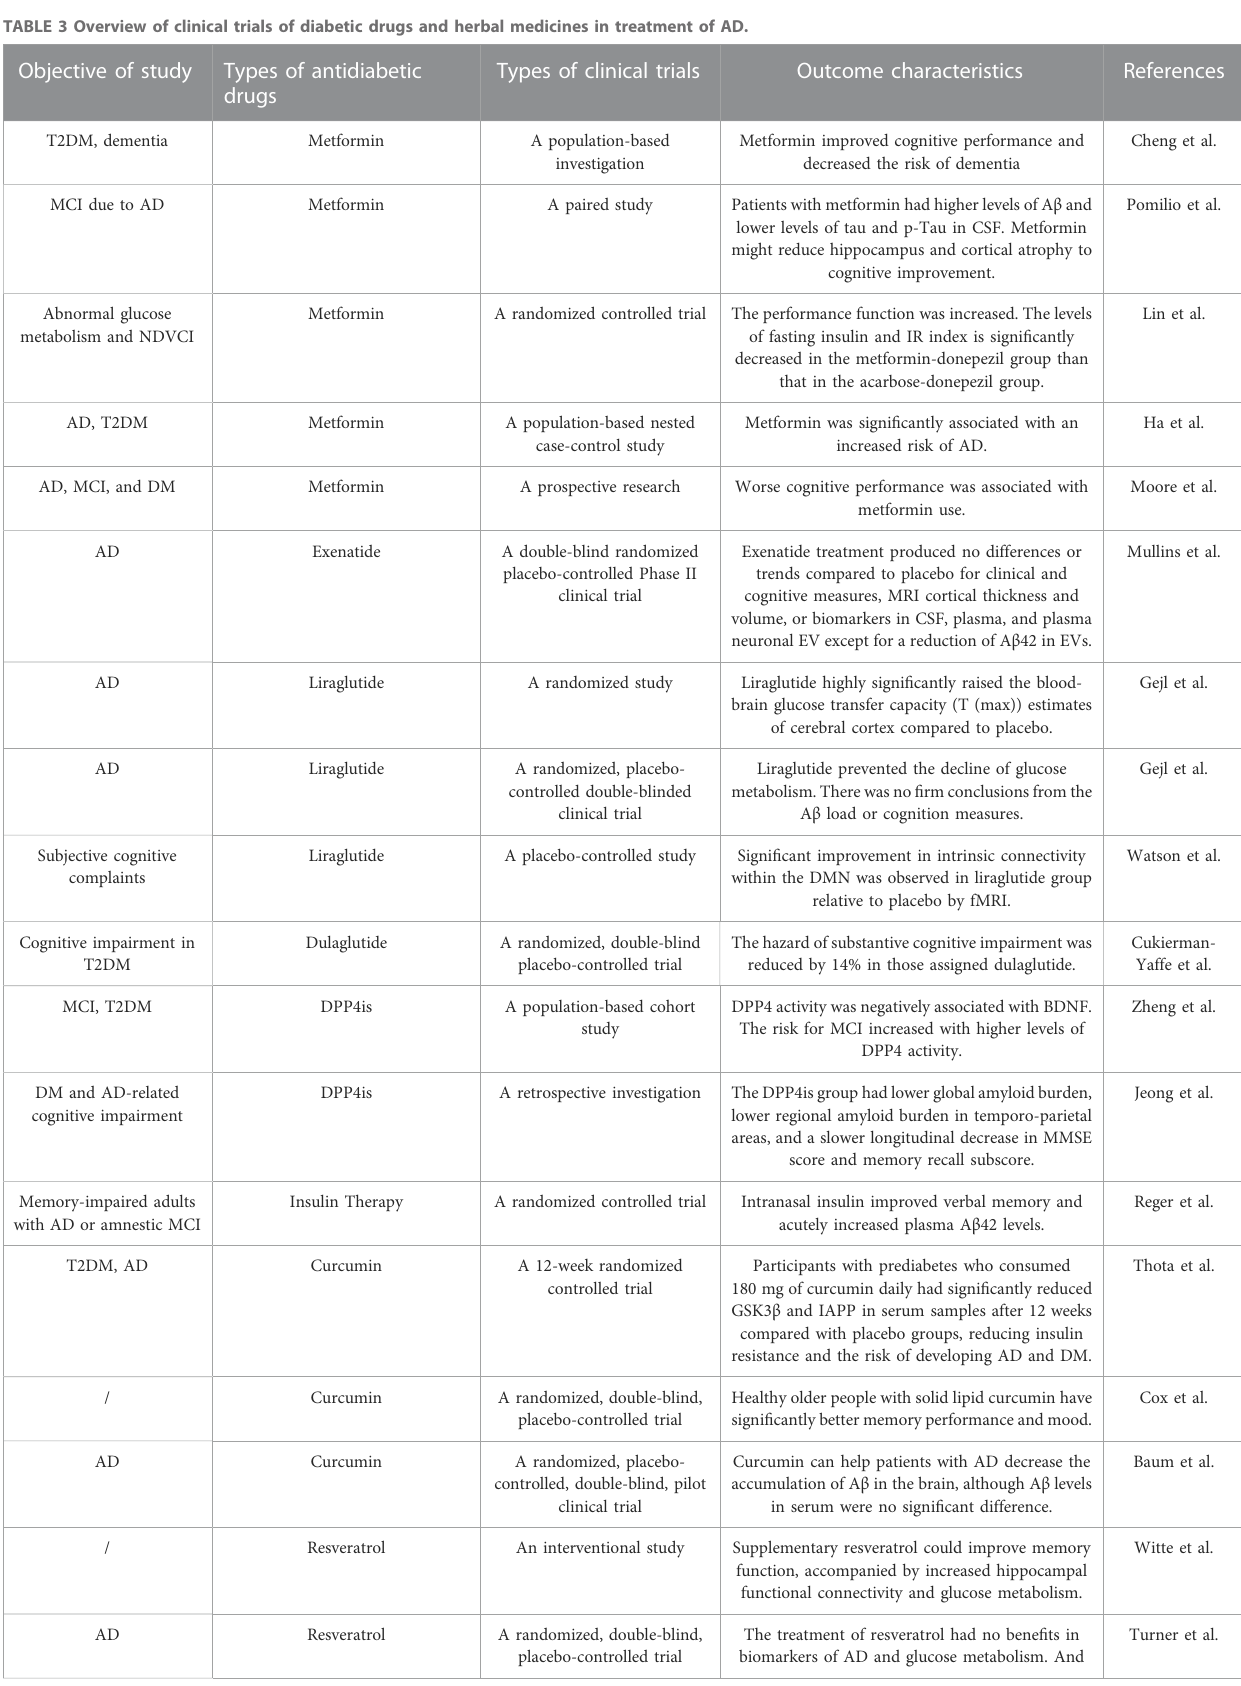
TABLE 3 Overview of clinical trials of diabetic drugs and herbal medicines in treatment of